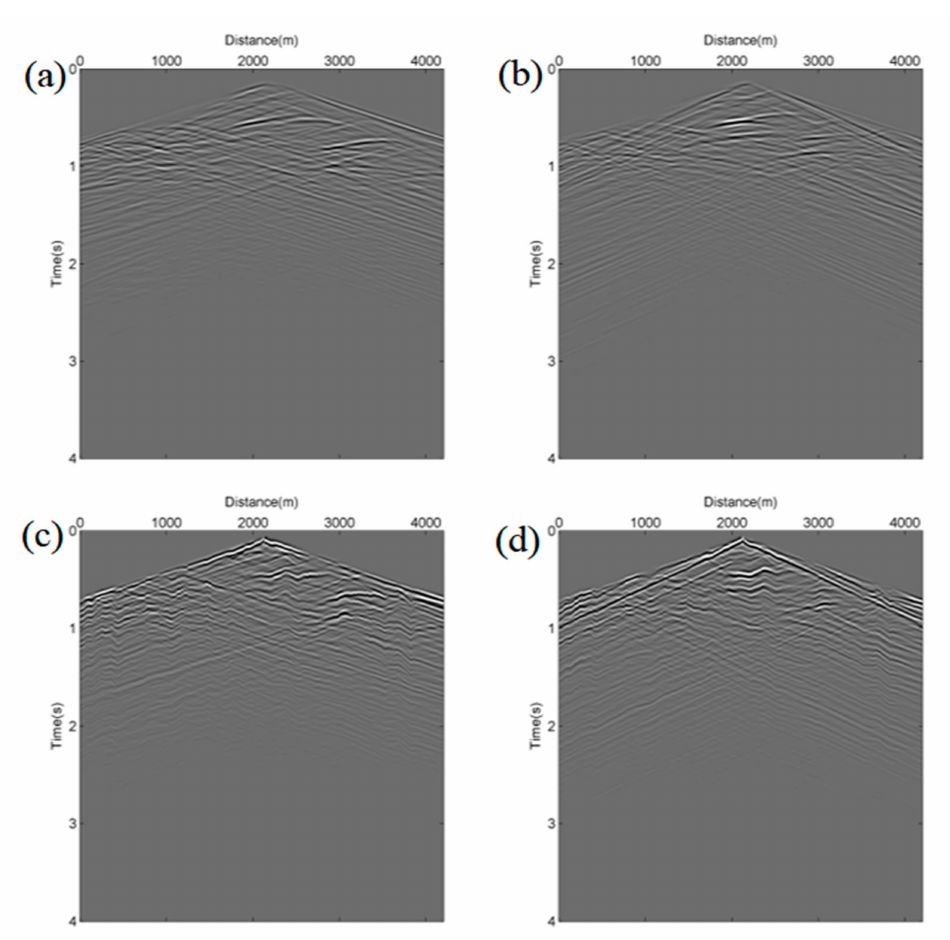
Figure 13. The noise-free common-shot gathers for modified Canadian Foothills elastic models with different topographies. The left panels are the horizontal component common-shot gathers, and the right panels are the vertical component common-shot gathers. Panels ( a , b ) are the common- shot gathers for modified Canadian Foothills elastic model with a horizontal topography, and panels ( c , d ) are the common-shot gathers for modified Canadian Foothills elastic model with a complex